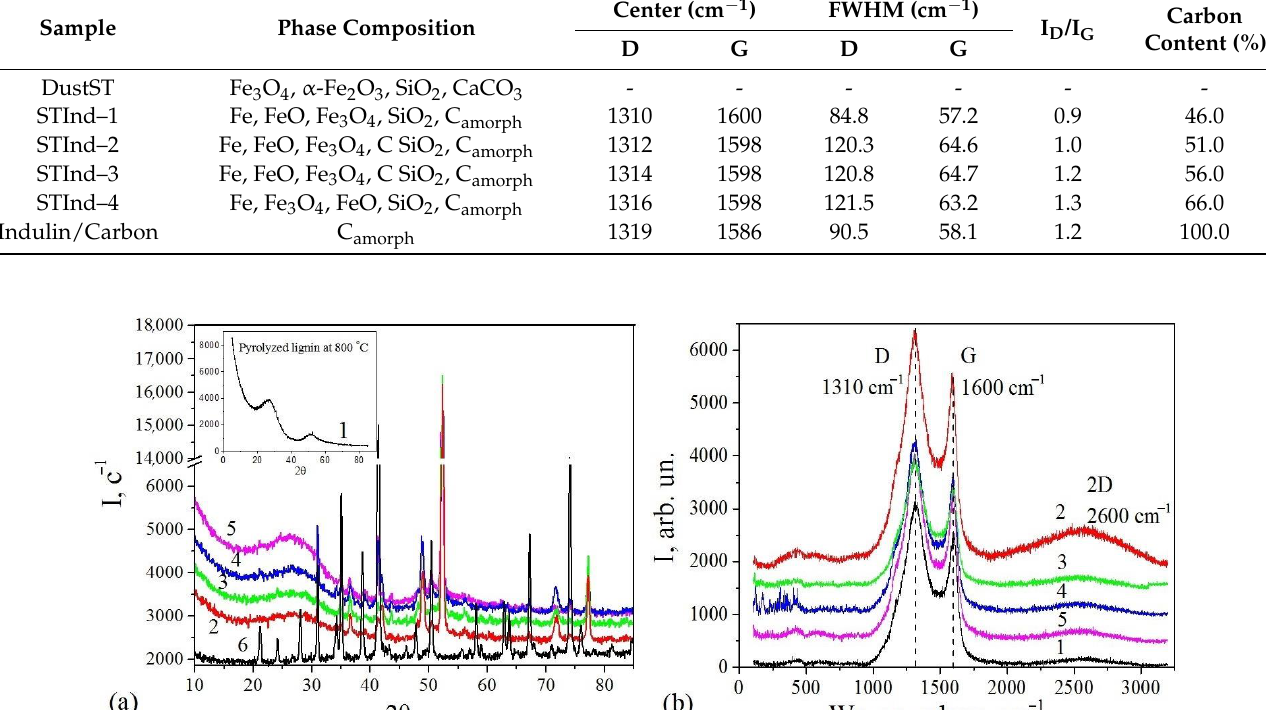
Figure 2. ( a ) XRD patterns and ( b ) Raman spectra of carbonized materials and furnace dust. 1: indulin/carbon; 2: STInd–1; 3: STInd–2; 4: STInd–3; 5: STInd–4; and 6: Table 4. Structural characteristics of biochars.